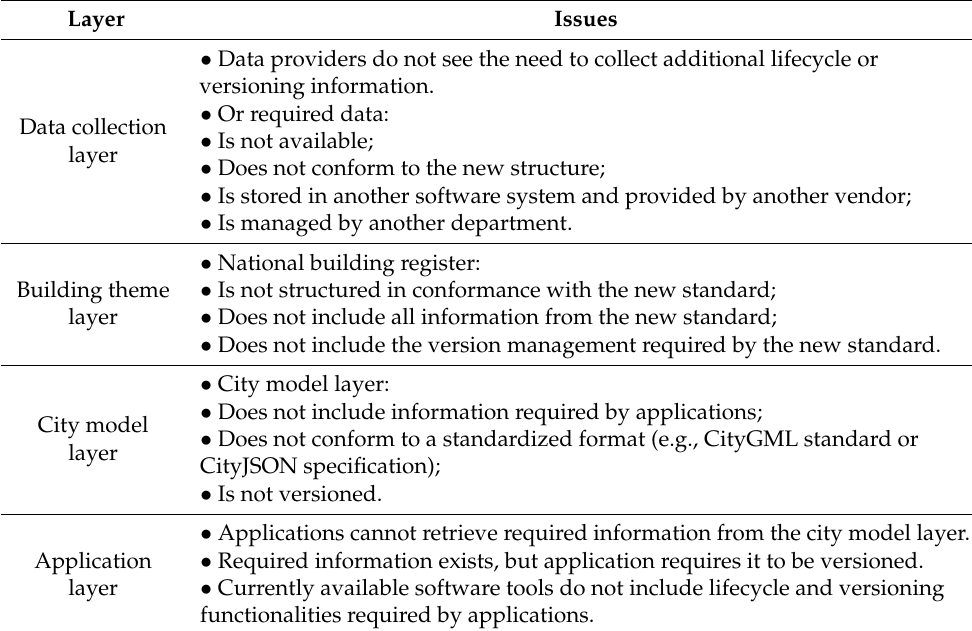
Table 3. Summary of issues for each layer in the model to provide 3D city